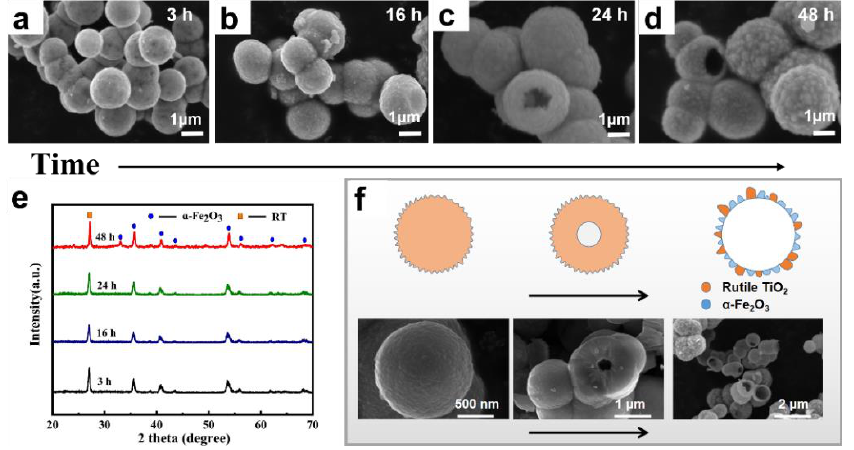
Figure 6. ( a – d ) SEM images of hollow α -Fe 2 O 3 /RT (0.025 mM), ( e ) XRD patter ns of hollow α - Fe 2 O 3 /RT (0.025 mM), and ( f ) schematic illustration of the formation of hollow α -Fe 2 O 3 /RT nano- spheres.